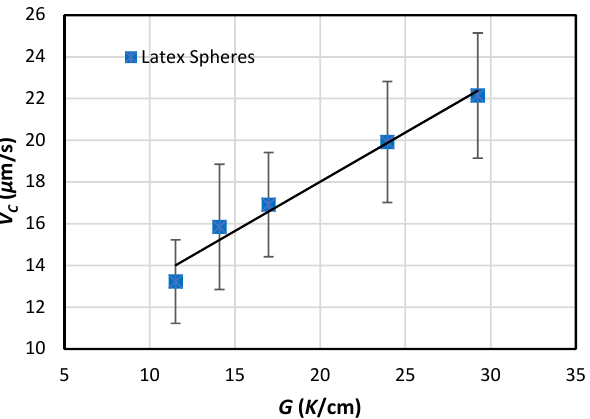
Figure 5. Relationship between PET velocity, V C , and temperature gradient for latex particles of 5.7 µ m mean diameter in distilled water solidified horizontally in thin specimens [26].